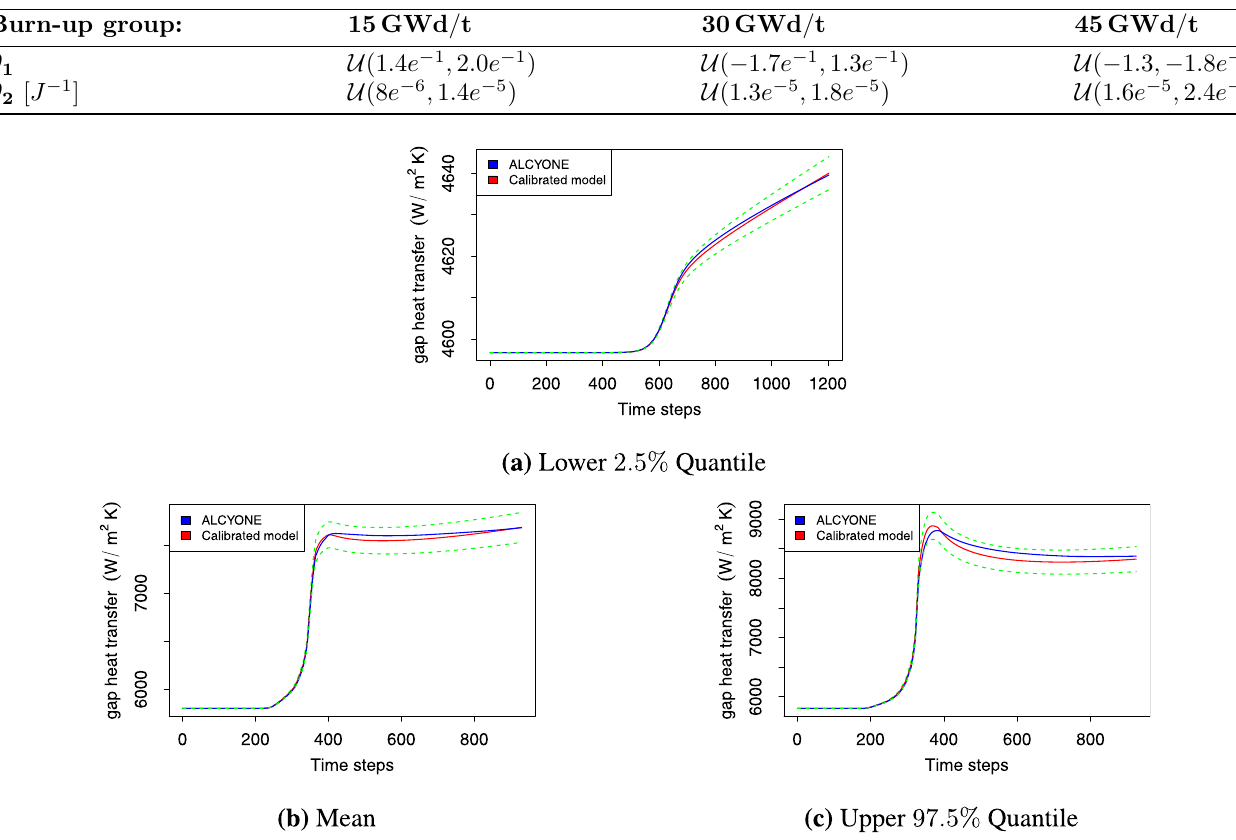
Table 5. Estimated distributions of Hgap model calibration parameters.